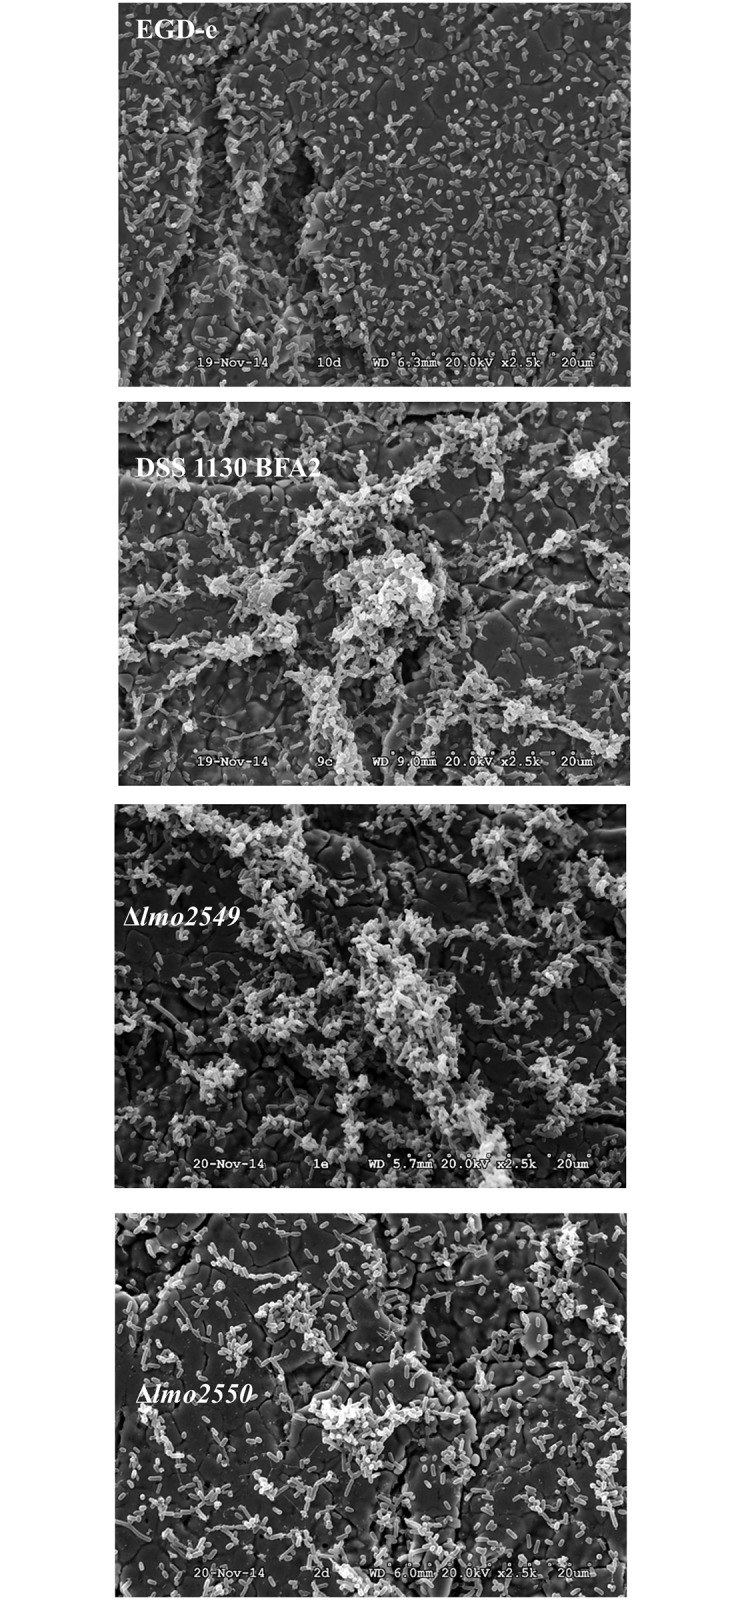
Scanning electron microscopy observations of 48h-biofilm of wild-type EGD-e strain, DSS 1130 BFA2, EGD-eΔlmo2549 and EGD-eΔlmo2550 mutants on stainless steel at 30°C in MCDB202 medium.